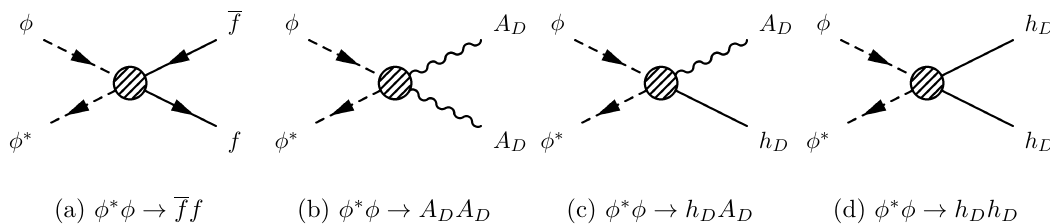
Figure 1. The four processes which dominantly contribute to the thermally averaged annihilation P σv cross section ∗ φ X in the Boltzmann equation written in eq. (3.1). Note that φ ∗ φ → X h i φ → h D A D and φ ∗ φ h D h D are only included in our calculations when the dominant h D decay is → h D A ∗ A D ffA D , as discussed in the D → →